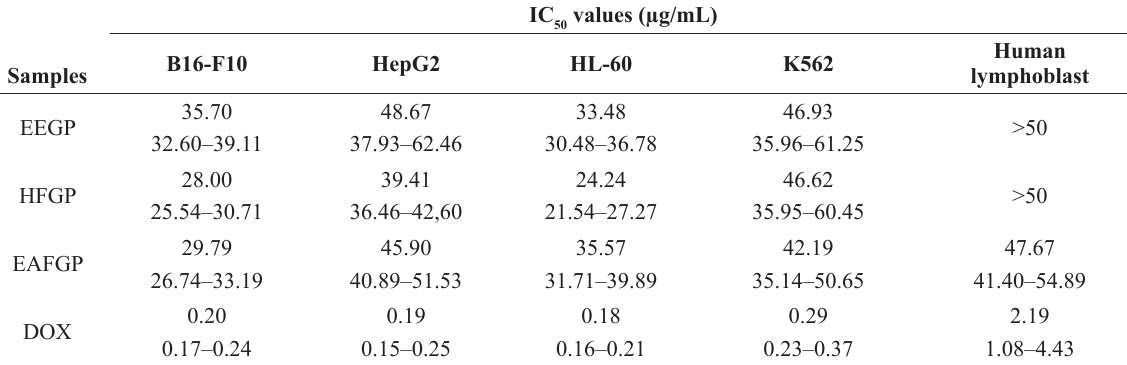
In vitro antiproliferative activities of Melipona mondury geopropolis ethanolic extract and its fractions .